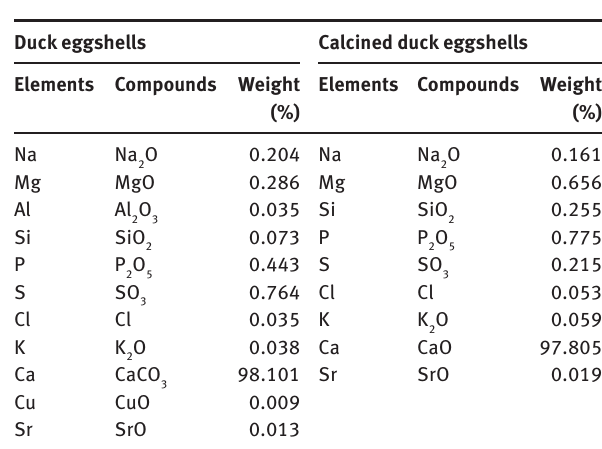
Table 1: Chemical compositions of raw materials as measured by XRF. Duck eggshells